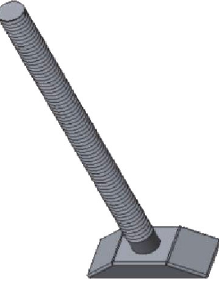
Figure 5: Di ff erent bottom connections of the